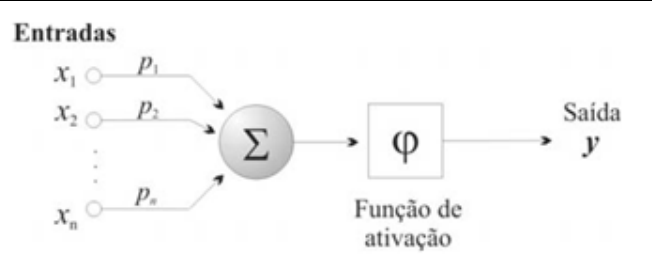
Figura 1: Modelo matemático de um neurônio.